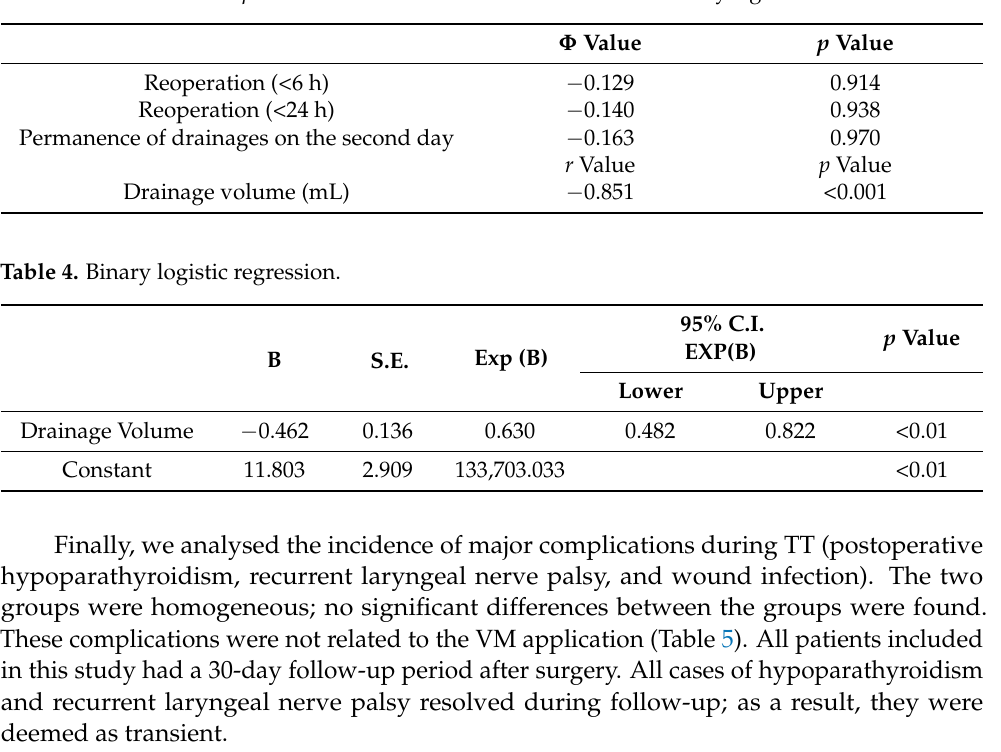
Table 3. Correlation tests. Phi coefficients were calculated for associations between dichotomous variables. Point-biserial correlations were calculated for correlations between dichotomous and continuous variables. A p value less than 0.05 was considered statistically significant.